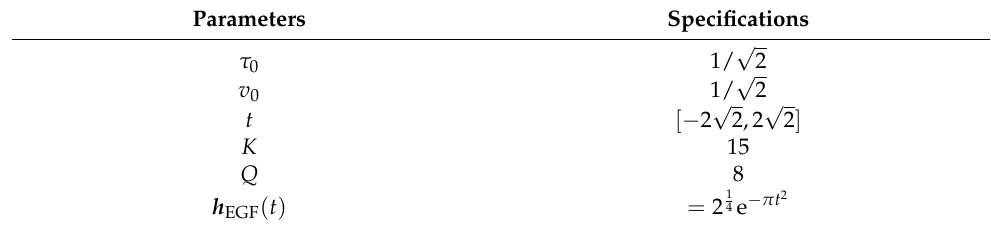
Table 1. Parameters of IOTA filter [29,30].